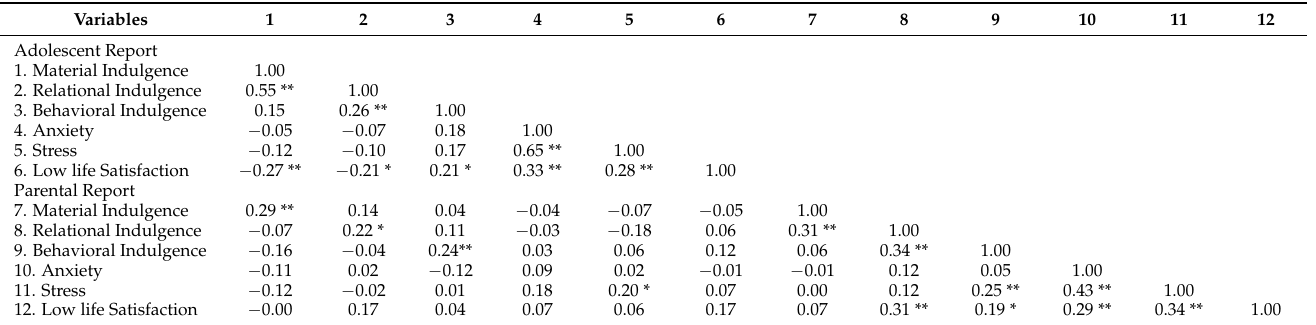
Table 2. Correlations for the study variables.